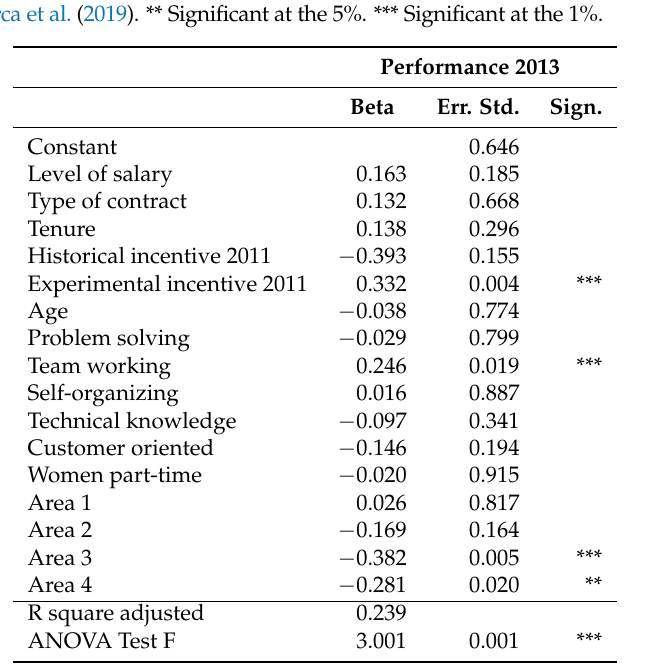
Table A2. Results of linear regressions described in Equation (6) considering all the life skill variables described in Cainarca et al. (2019). ** Significant at the 5%. *** Significant at the 1%.